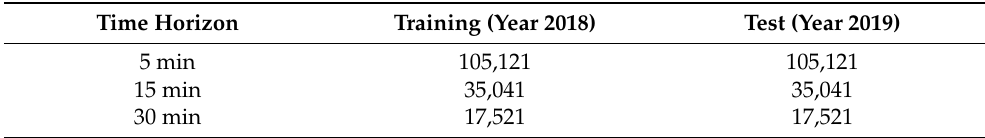
Table 2. Database division and number of records. Time